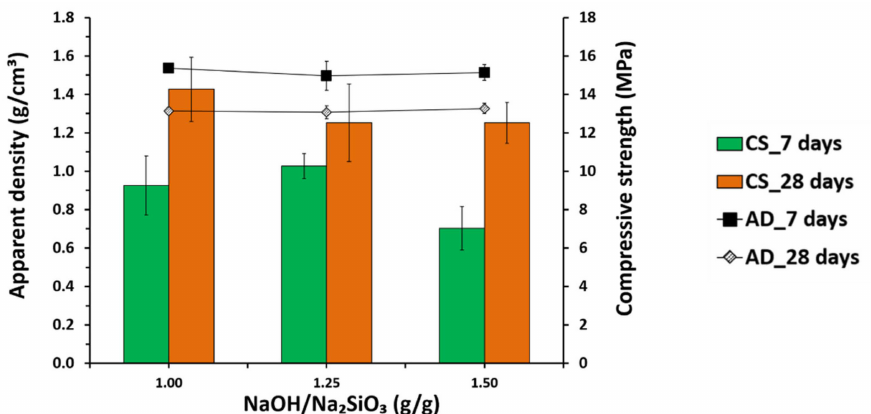
Figure 5. The apparent density and compressive strength of the alkali activated binders at 7 and